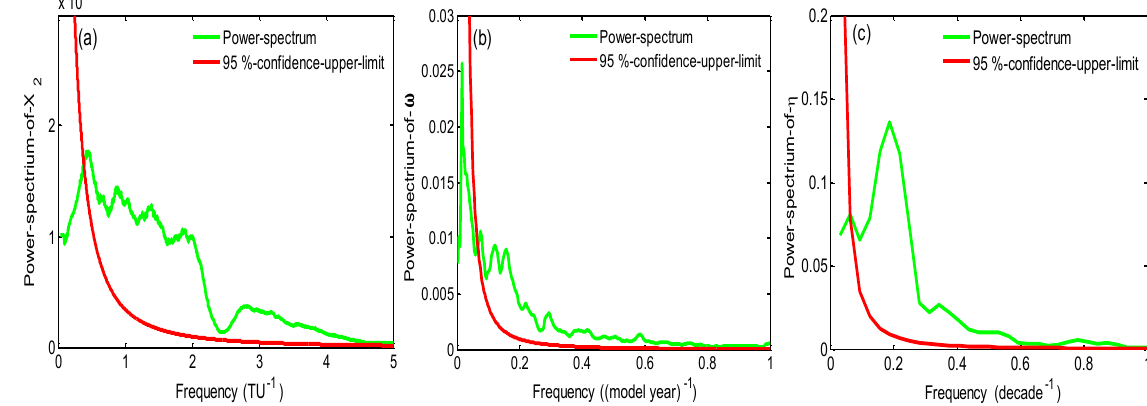
Figure 3. The power spectrum (green) of (a) X 2 (b) ω , and (c) η based on the model states between 5000 and 9800TUs integrations after the spinup which integrates for 10000TUs from the initial condition (0, 1, 0, 0, 0) with respect to the frequency, with 95% statistical significance (red).